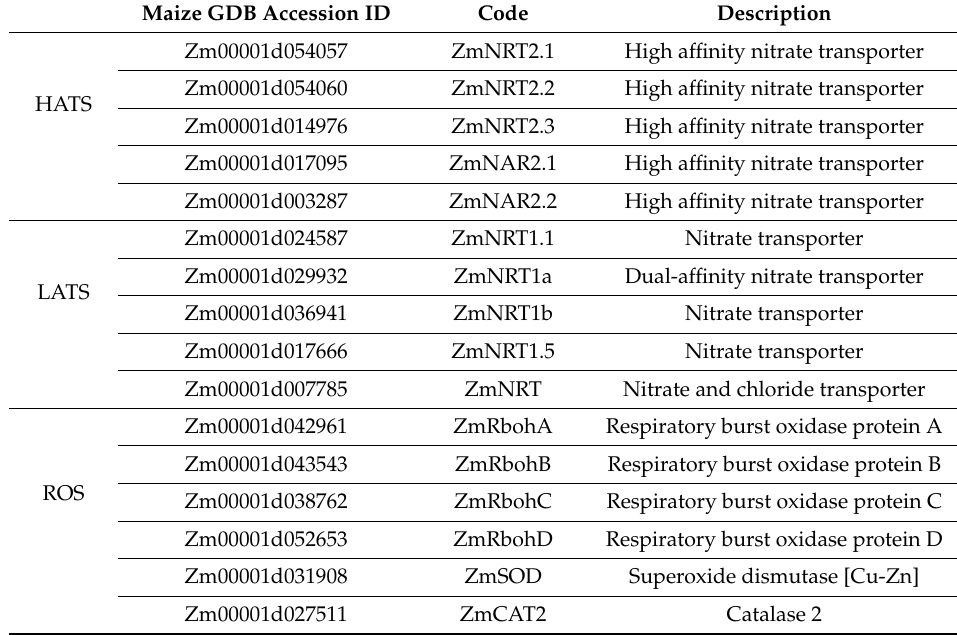
Table 1. Description and classification of the targets genes studied in qPCR expression analysis. The expression levels of genes belonging to nitrate transport system (HATS and LATS) and related to reactive oxygen species (ROS) generation and homeostasis were